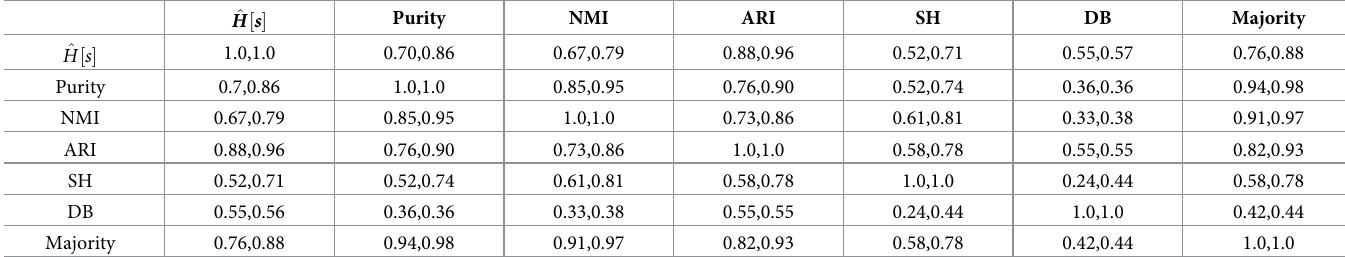
Fig 6. H[S] versus purity, NMI and ARI for Leaf (top) and Abalone (below) datasets. https://doi.org/10.1371/journal.pone.0239331.g006 Table 13. Kendall’s τ and Spearman’s correlation result for Leaf.